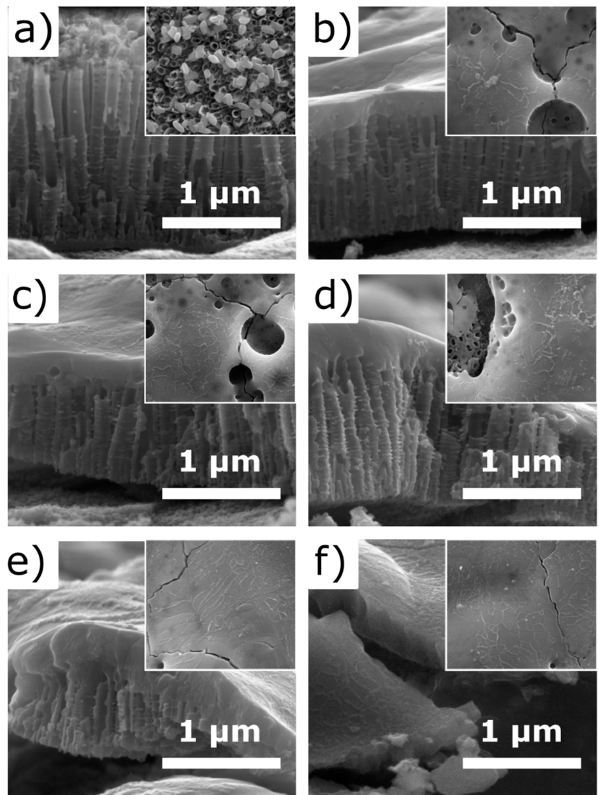
Figure 2. SEM images of laser-treated titania nanotubes (TiO 2 -NTs) covered by 10 nm Fe film from top (inset) and side. Images show the samples ( a ) untreated and treated by laser of ( b ) 40 mJ / cm 2 , ( c ) 80 mJ / cm 2 , ( d ) 120 mJ / cm 2 , ( e ) 160 mJ / cm 2 , and ( f ) 200 mJ / cm 2 fluence.